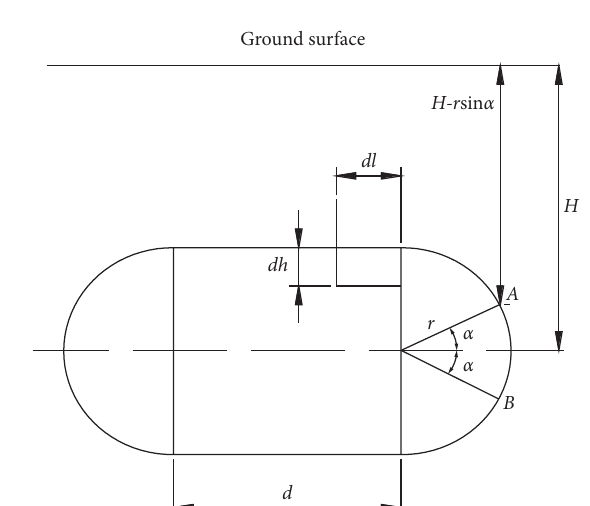
Figure 6: Simplified cross section of shield machine.